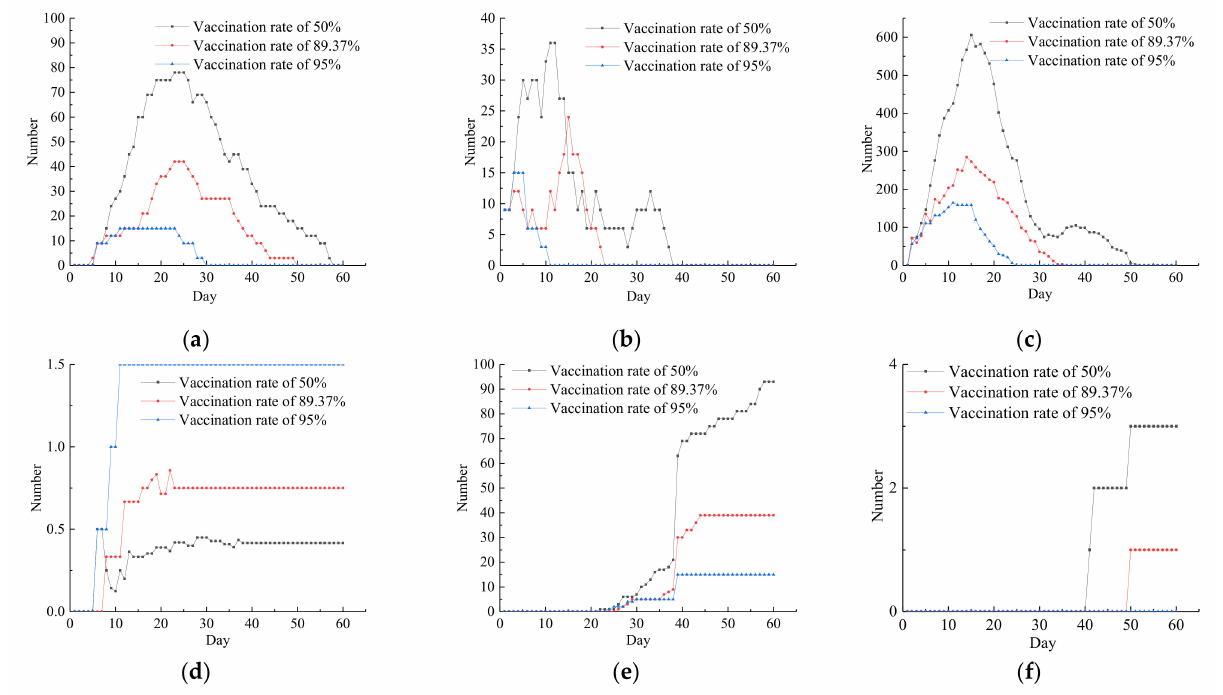
Figure 8. Vaccine intervention scenario: ( a ) changes in the number of confirmed cases; ( b ) changes in the number of potential infections; ( c ) changes in the number of close contacts; ( d ) proportion of mild-to-severe cases; ( e ) changes in the cumulative number of cured agents; ( f ) cumulative death toll.